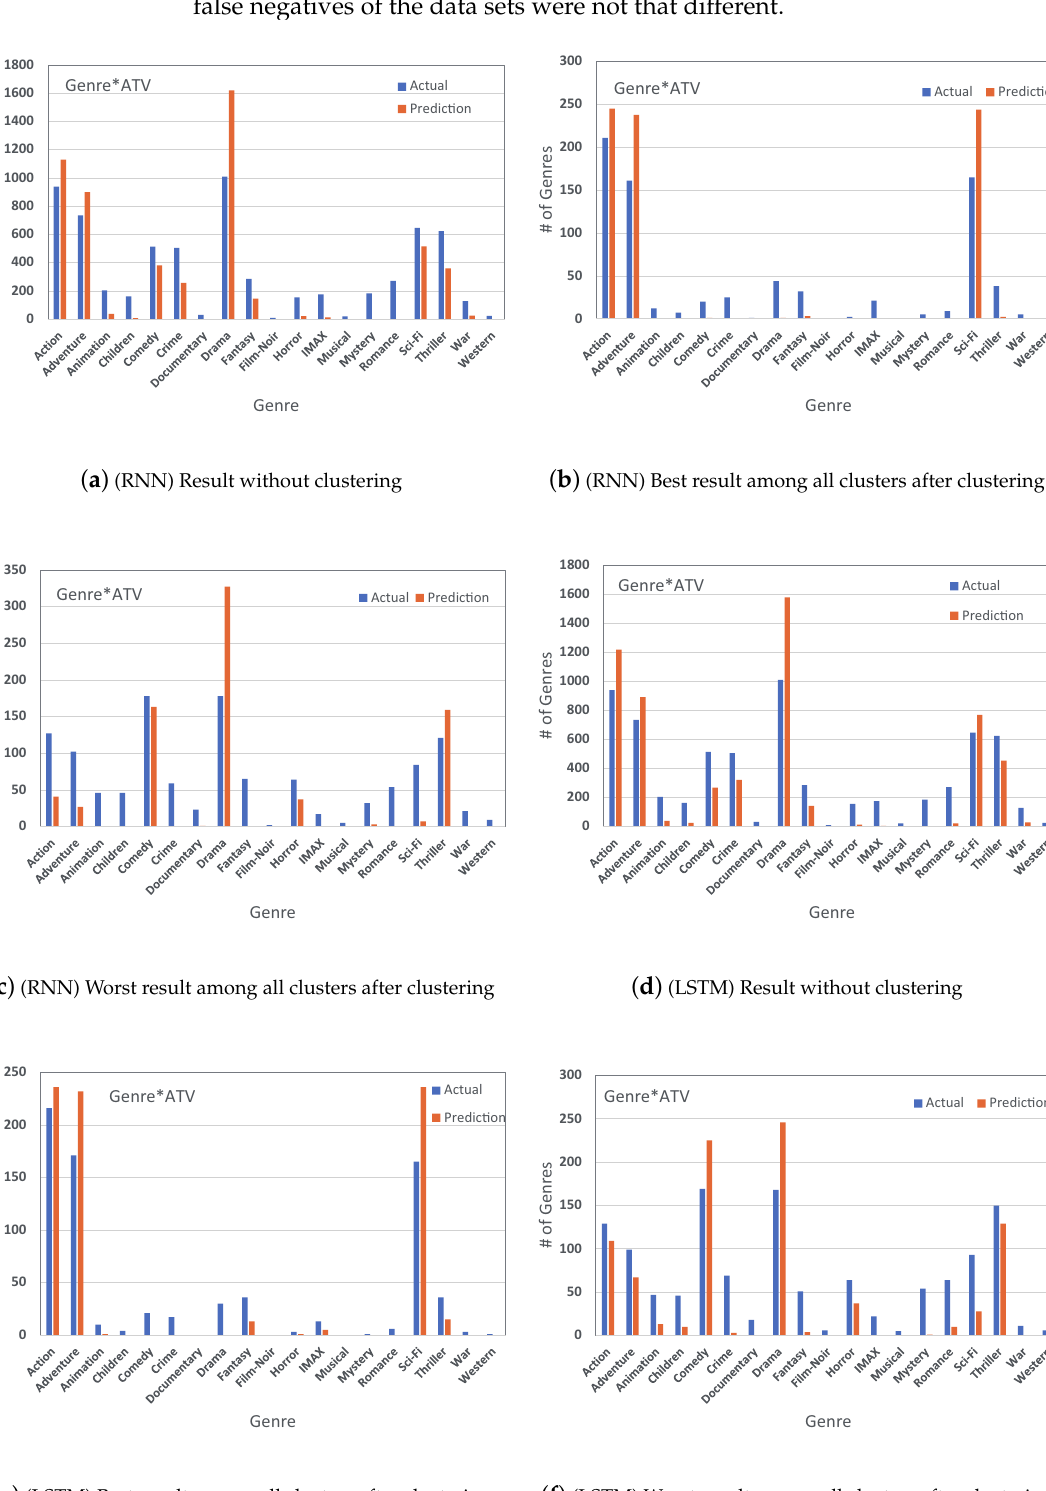
( f ) (LSTM) Worst result among all clusters after clustering Figure 11. Cont